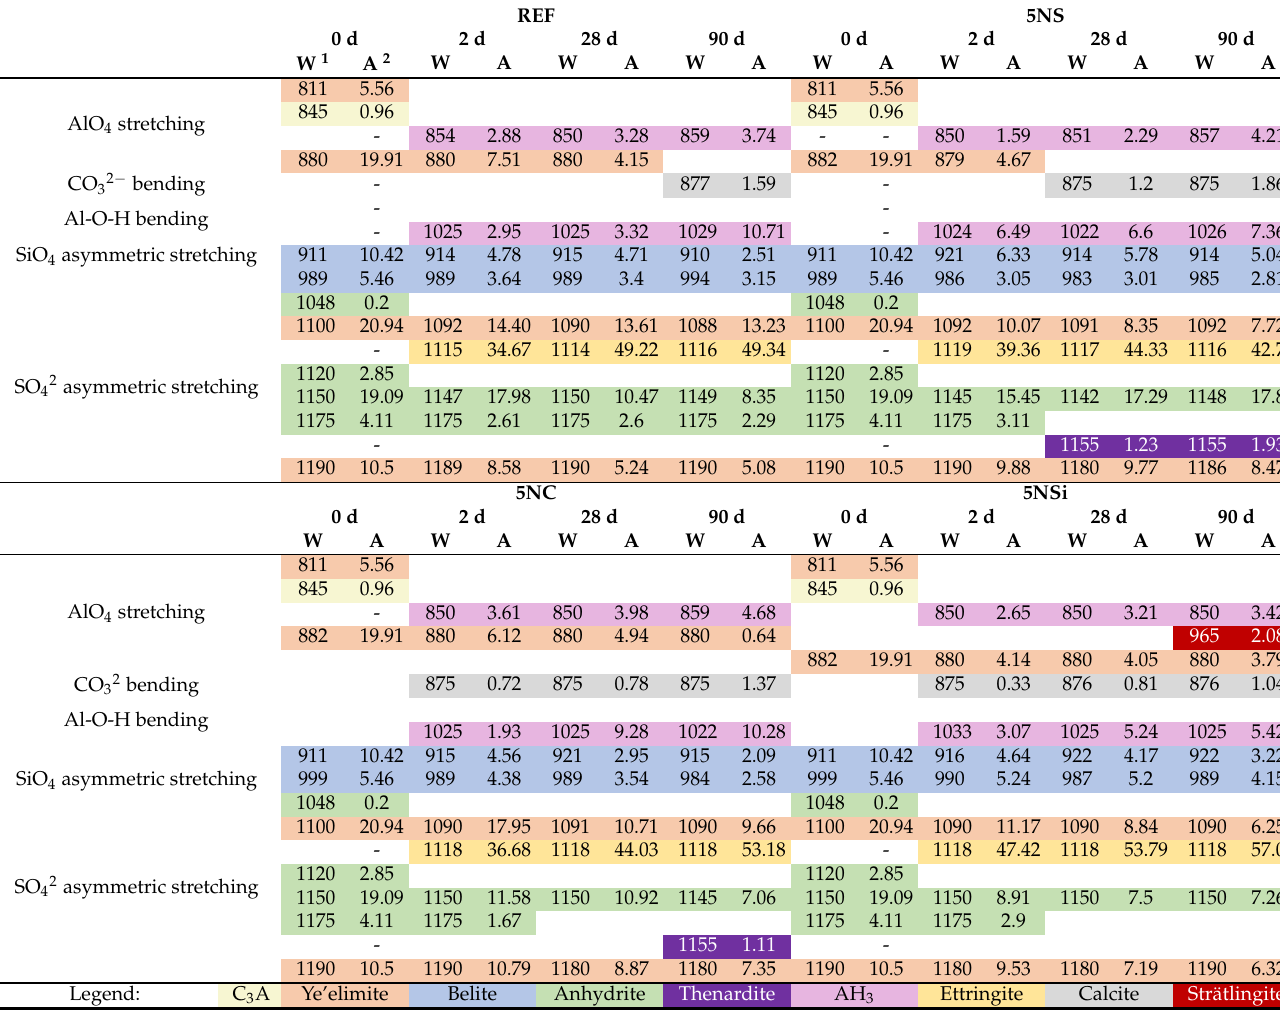
Table 2. FTIR spectrum band positions and areas (in per cent of total) of the reaction products in all systems at all ages